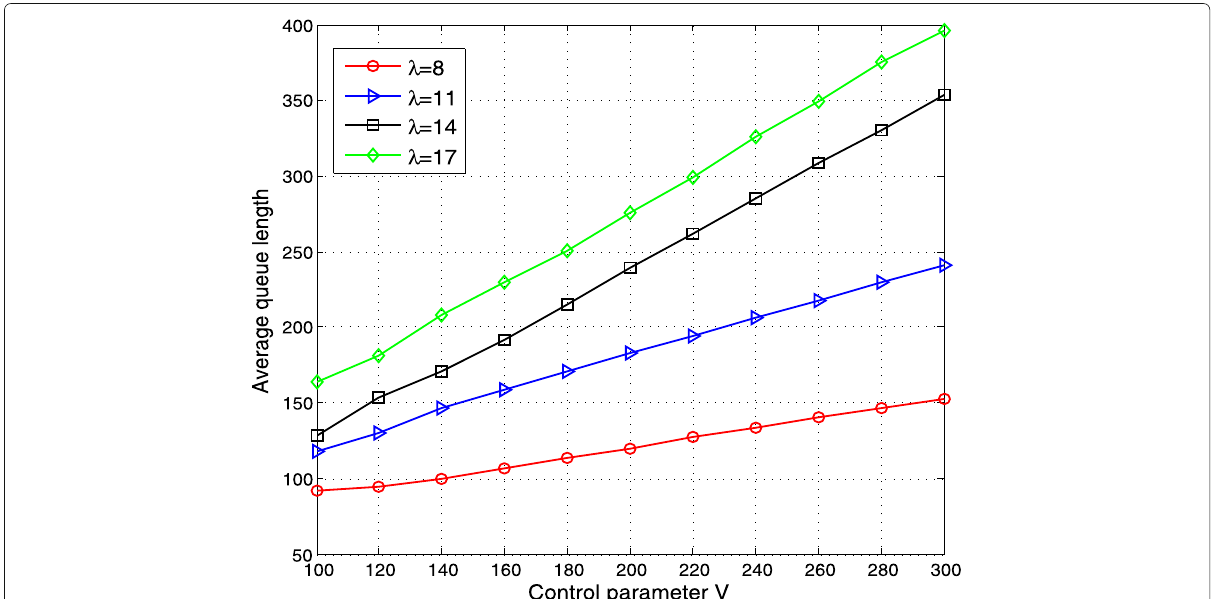
Fig. 5 The average queue length versus the control parameter V with different λ